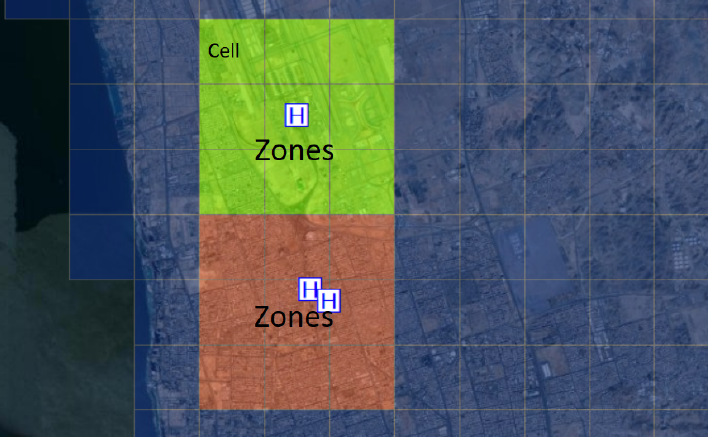
Figure 4. An illustration of the spatial distribution of the cells and zones in a geographical area, where the letter H indicates medical facilities or vaccination centers.